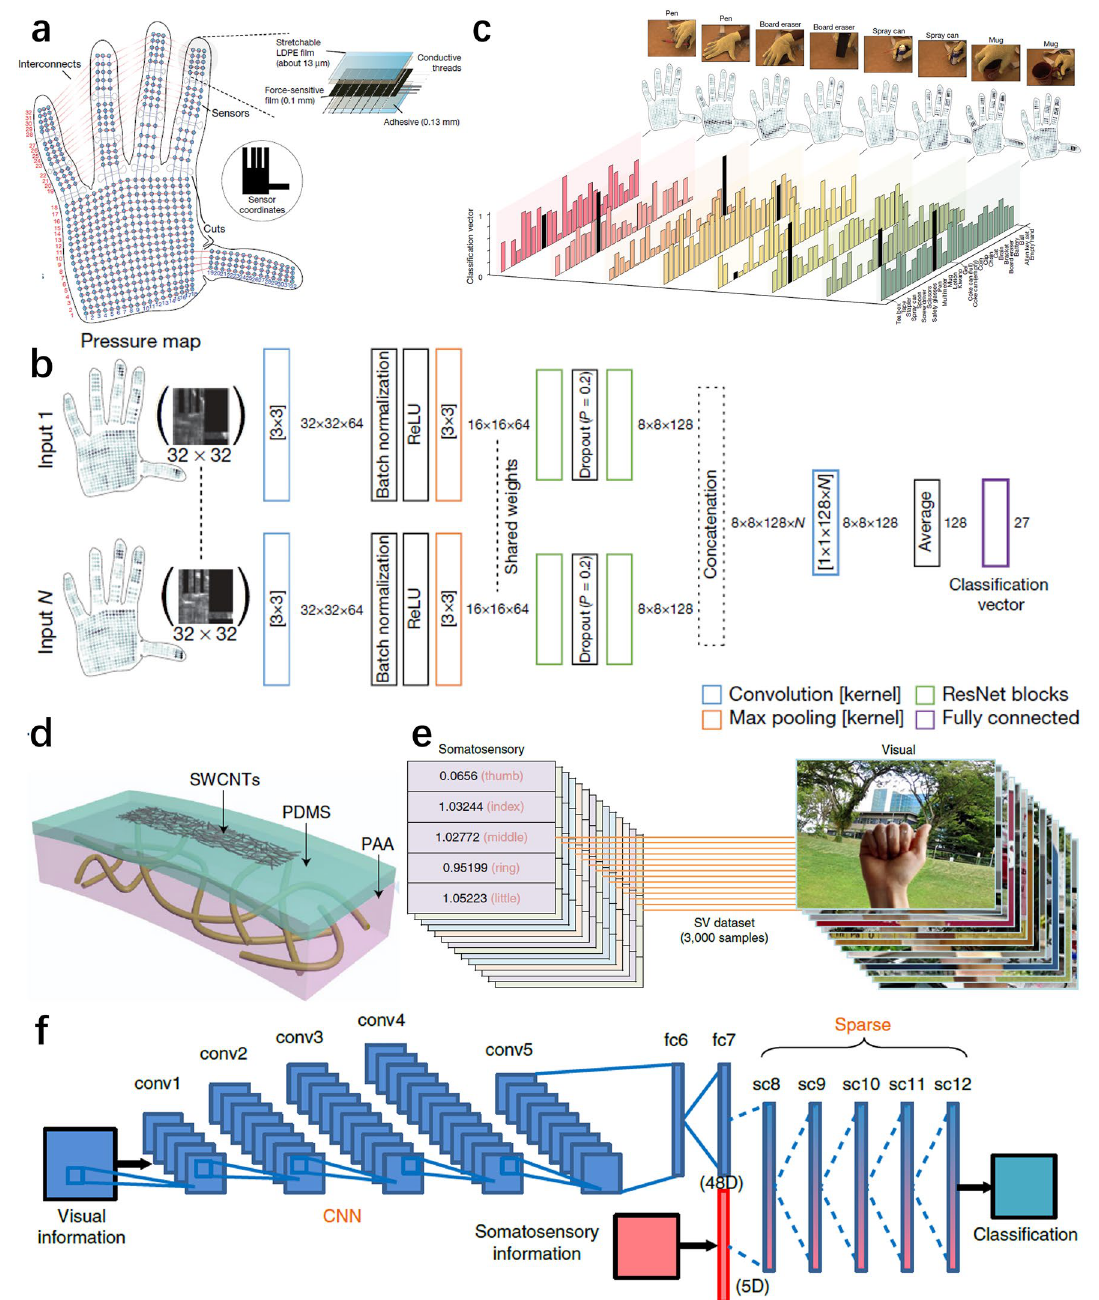
Fig. 27 Mechanical signals detected by soft sensor and analyzed by CNN. a STAG architecture consisting of the individual locations of the 548 sensors, along with the interconnects, slot, and 64 electrodes. The piezoresistive sensor array can be divided to different architectures. b CNN architecture applied for identifying objects with the input N arrays of tactile data (32 × 32 arrays). c Tactile maps, corresponding visual images, and the classification results from single tactile map inputs. The ground-truth object labels are marked in black. Reproduced with permission [340]. Copyright (2019), Springer Nature. d Diagram of the conformable, transparent, and adhesive stretchable strain sensor. e Illustration of the SV dataset containing 3000 SV samples. f Diagram of the BSV algorithm. Reproduced with permission [342]. Copyright (2020), Springer